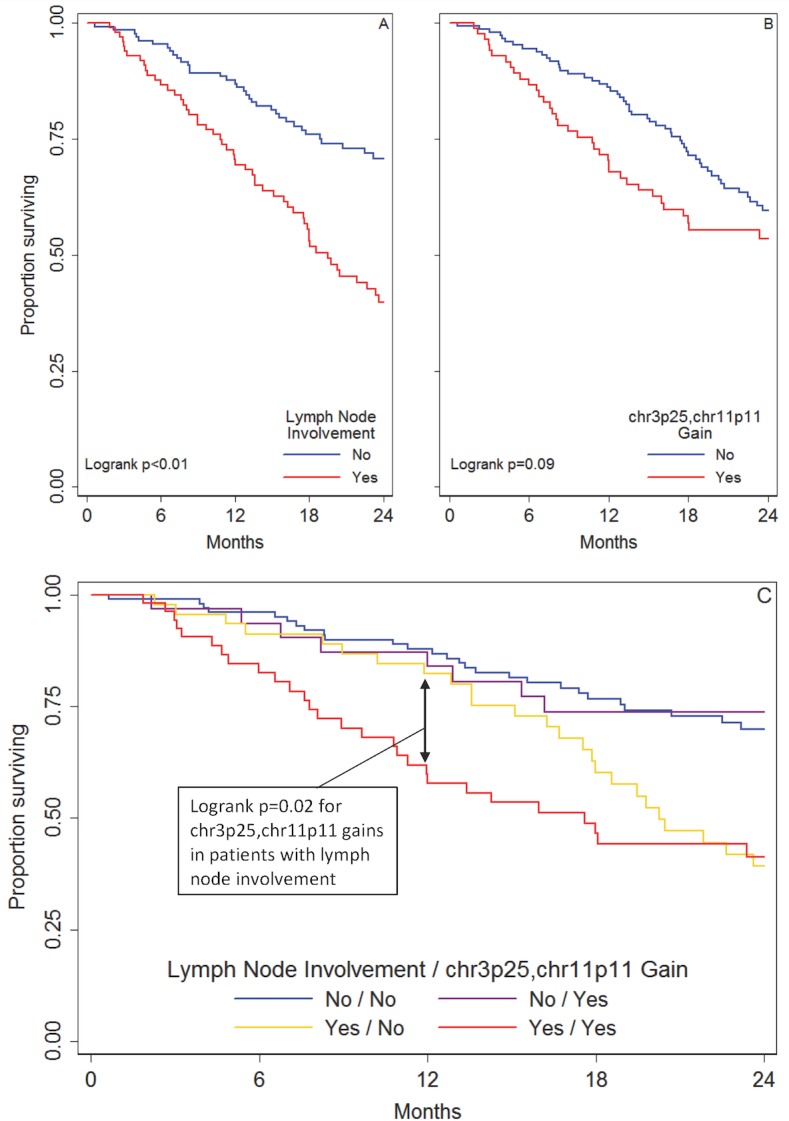
Kaplan-Meier survival curves for 24-month survival.A. By lymph node involvement, B. By chr3p25, chr11p11 gain. C. By lymph node involvement and chr3p25, chr11p11 gain.